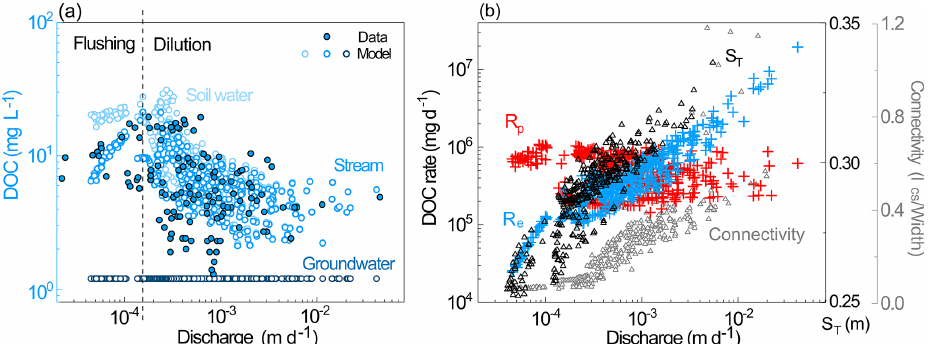
Figure 7. (a) Relationship of daily discharge ( Q ) with stream DOC concentration: open circles are simulations and filled circles with a black outline are data. (b) Relationship of daily discharge ( Q ) with soil water storage S T , connectivity ( I cs / Width), the catchment-scale DOC export rate R e , and the DOC production rate R p . At low Q , the stream water transitioned from organic-poor groundwater to organic-rich water from the valley floor and swales, leading to a flushing (positive) pattern. At higher Q , the stream water shifted from organic-rich soil water from swales and valley areas to lower DOC water from planar hillslopes and uplands, decreasing the stream DOC concentration and resulting in a dilution C–Q pattern. R e increased by 2 orders of magnitude with increasing Q , whereas R p varied within an order of magnitude.